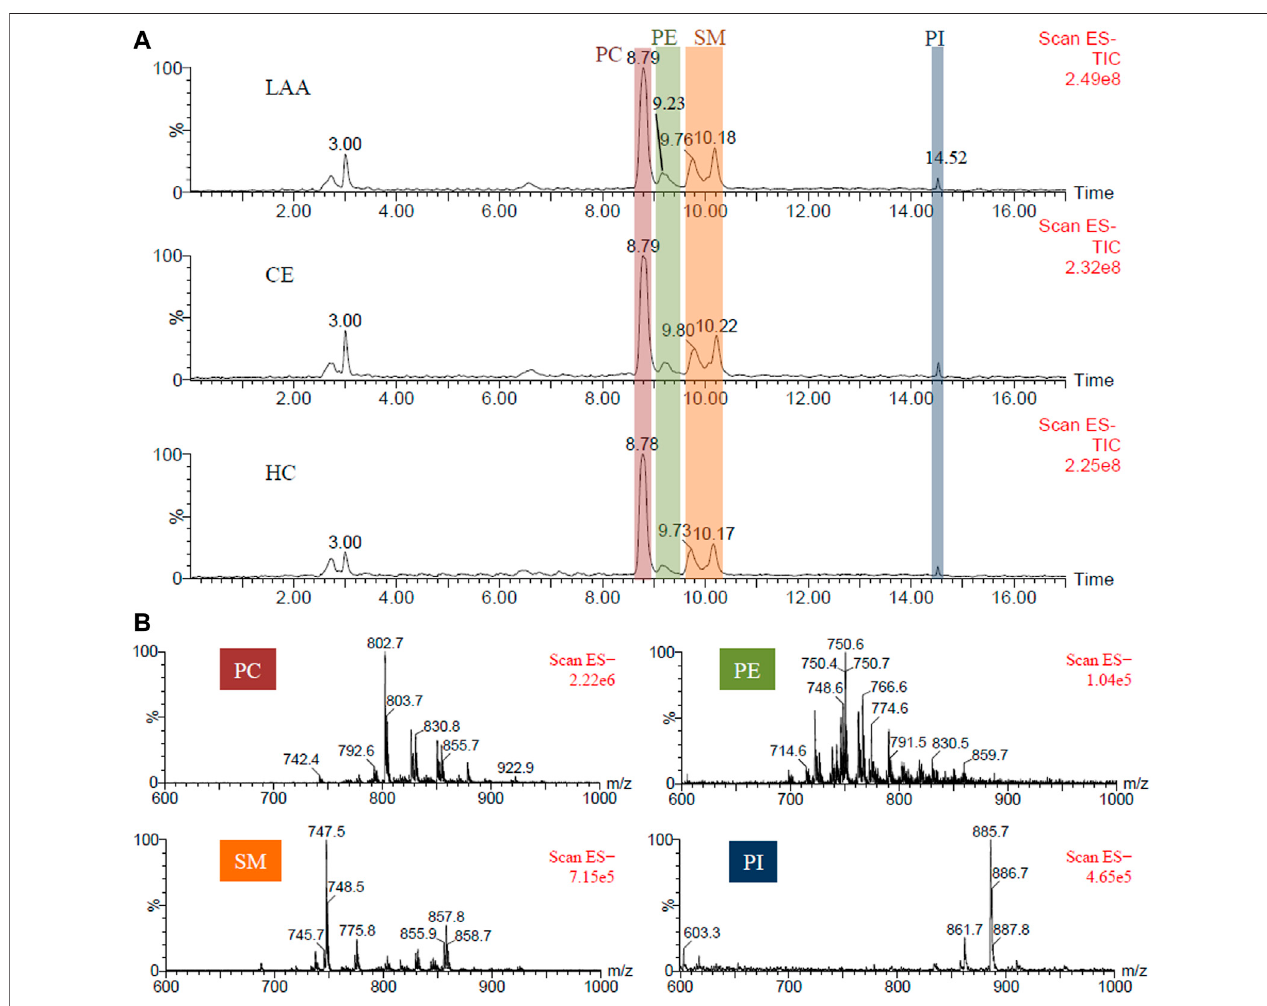
FIGURE1|(A). The representative TIC chromatogramsofPLs extracted from the plasma ofLAAand CE patients, and HC participants respectively; (B) The mass spectra of PC, PE, SM, and PI components.